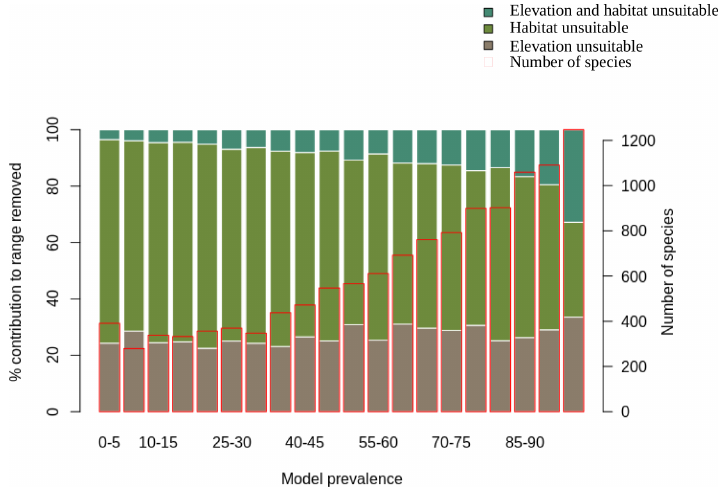
Figure 1. Percentage contribution of elevation range, habitat and both in clipping the IUCN range to produce AOH maps for birds. Each bar represents a 5% bin of model prevalence, divided to show how much of the range was clipped out due to unsuitable habitat at suitable elevations (“habitat unsuitable”), by suitable habitat at unsuitable elevations (“elevation unsuitable”) and by unsuitable habitat at unsuitable elevations (“elevation and habitat unsuitable”). The red blocks correspond to the second y -axis and show the number of species falling into each 5% bin of model prevalence.